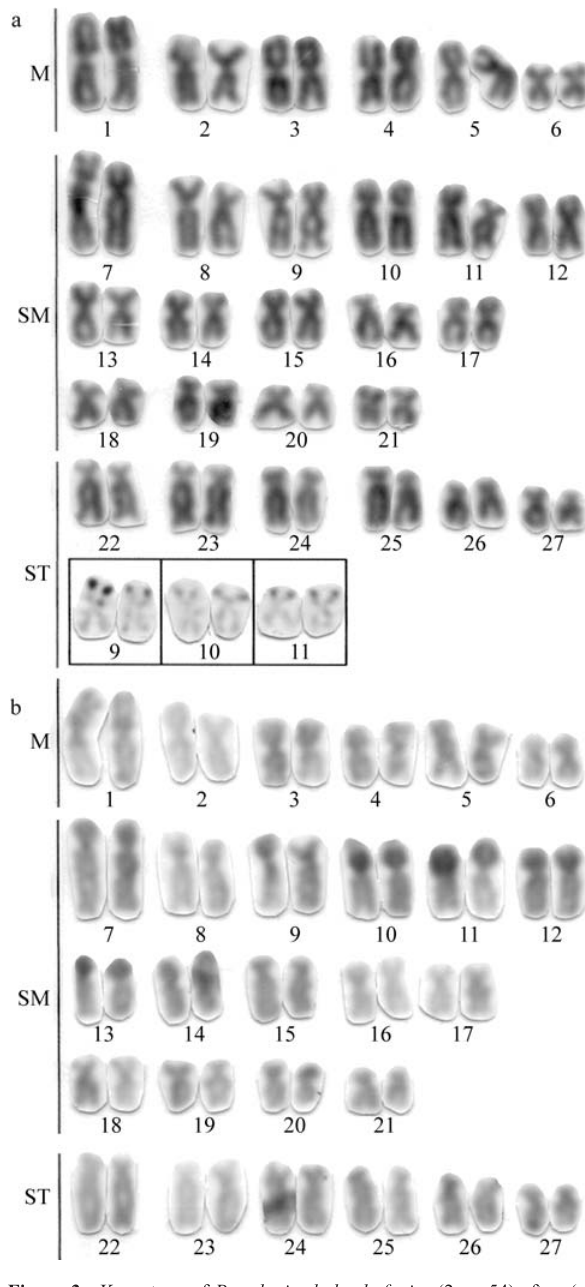
Figure 3 - Karyotype of Pseudopimelodus bufonius (2n = 54) after: (a) conventional staining and (b) C-banding. In the inset, silver stained chro- mosomes showing the terminal Ag-NORs on the long arms of pairs 9, 10 and